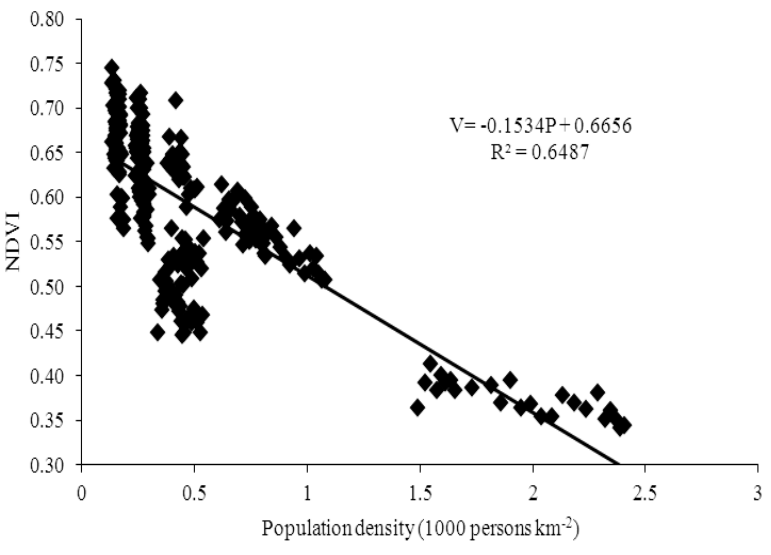
Figure 7. The scatterplot of population density and NDVI with fitted curve in low-urbanization cities from 1982 to